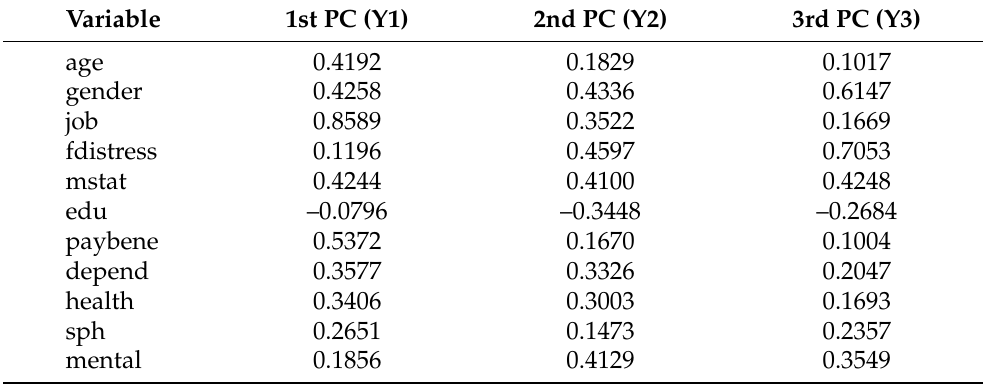
Figure 2. Visualization of profiles. MDS based on Gower’s projection and final data visualization. Table 2. Correlations/associations among the original variables and the first three principal